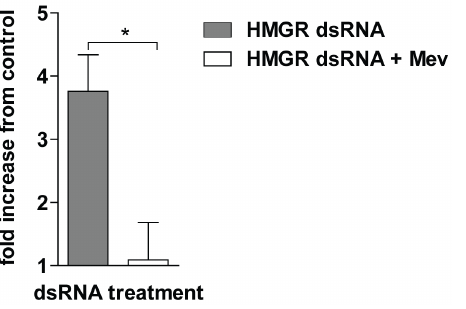
Figure 7. RNAi of SmHMGR induces apoptosis in somules, which is preventable by excess mevalonate. Somules were incubated with dsRNA to HMGR ( 6 500 m M mevalonate) or mCherry for 25 days. Caspase activity was then measured using the fluorescent substrate Z-DEVD-R110 as described in the text. Data are expressed as the fold increase in caspase activity relative to somules exposed to mCherry dsRNA. Bars represent means 6 S.D. across two independent experiments. Significance (p , 0.05) was measured using Student’s t -test and is indicated with an